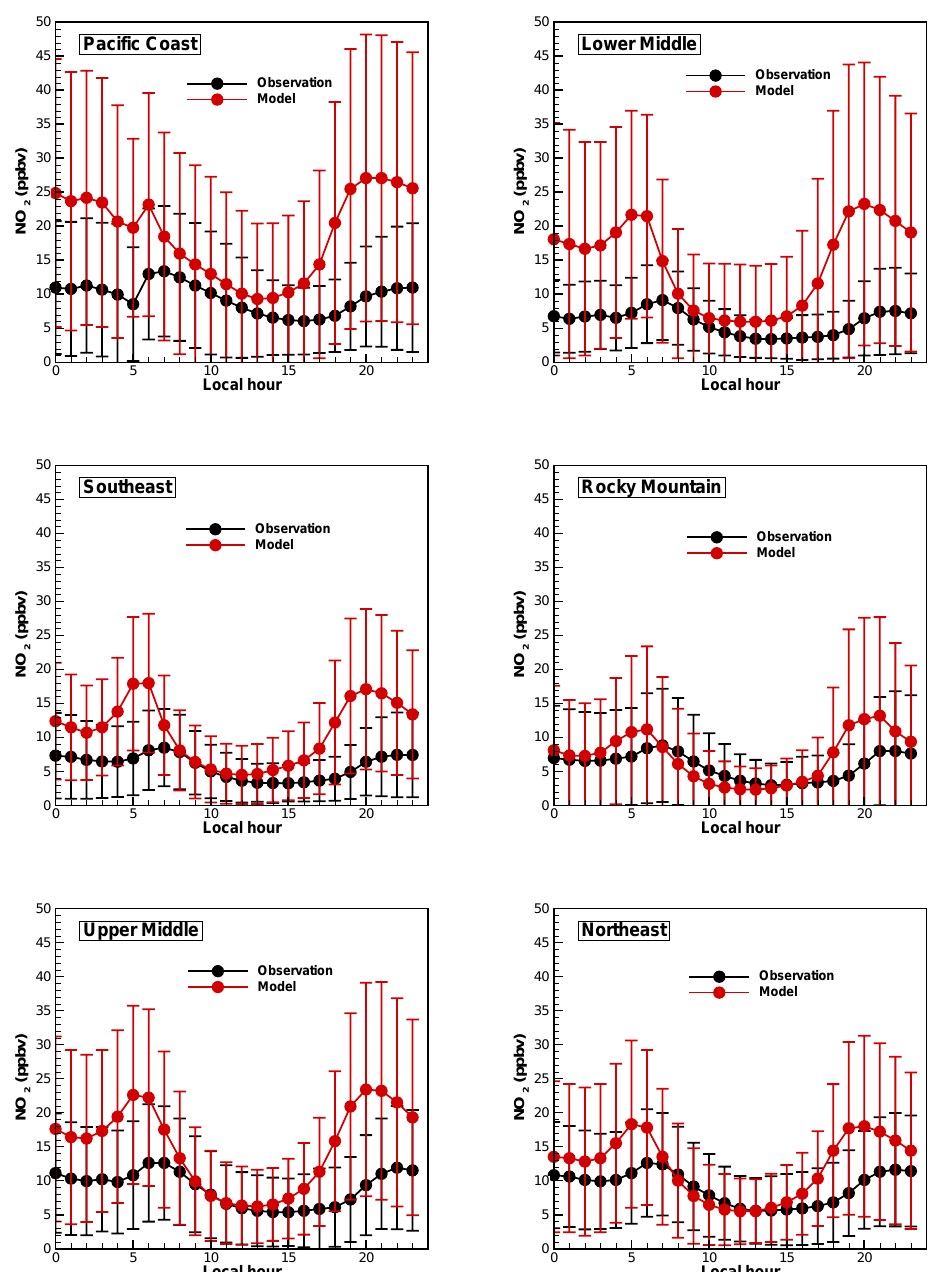
Fig. 12. Diurnal profiles of NO 2 in August 2010 for each of the six regions listed in Fig. 1. Average concentrations of the AQS observations and their NAQFC counterparts are shown with their standard deviations as a function of local